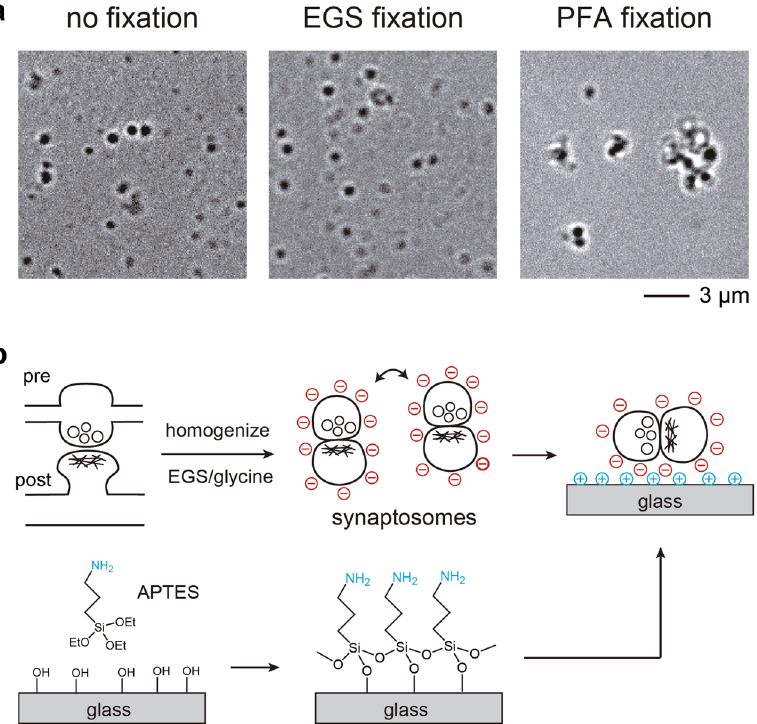
Figure 1. ( a ) Brightfield images showing non-fixed, 2 mM EGS-fixed, and 1% PFA-fixed synaptosomes captured over APTES-functionalized coverglass. ( b ) Schematics for the isolation of synaptosomes from brain tissues, followed by EGS fixation and attachment to APTES-functionalized